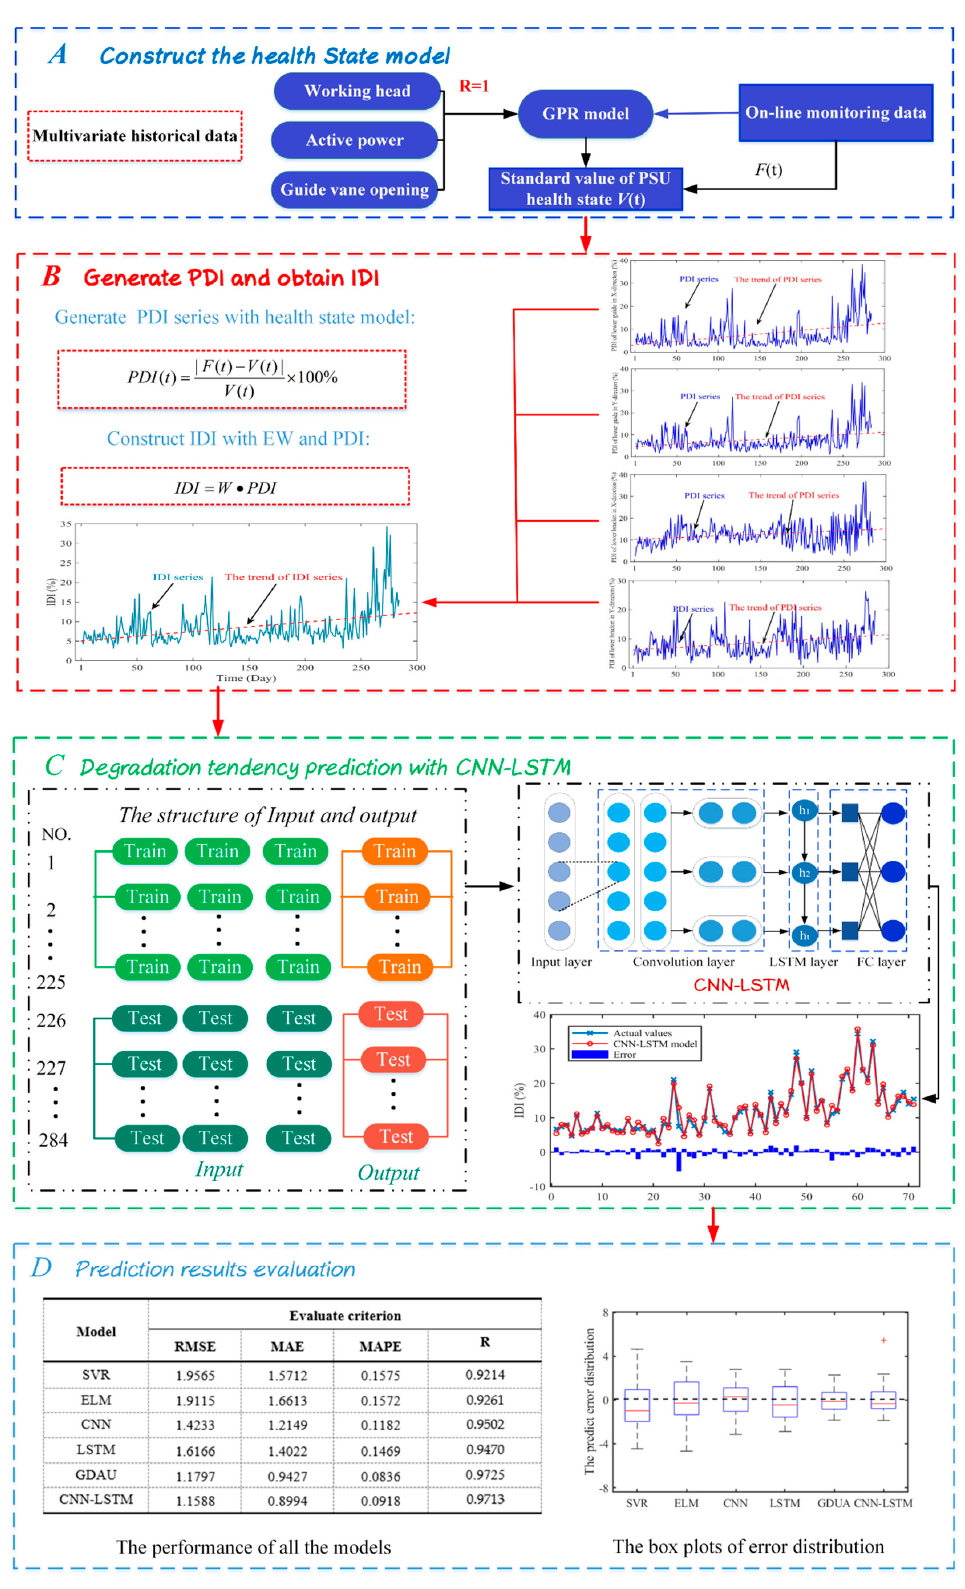
Figure 2. The flowchart of the proposed DTP model .